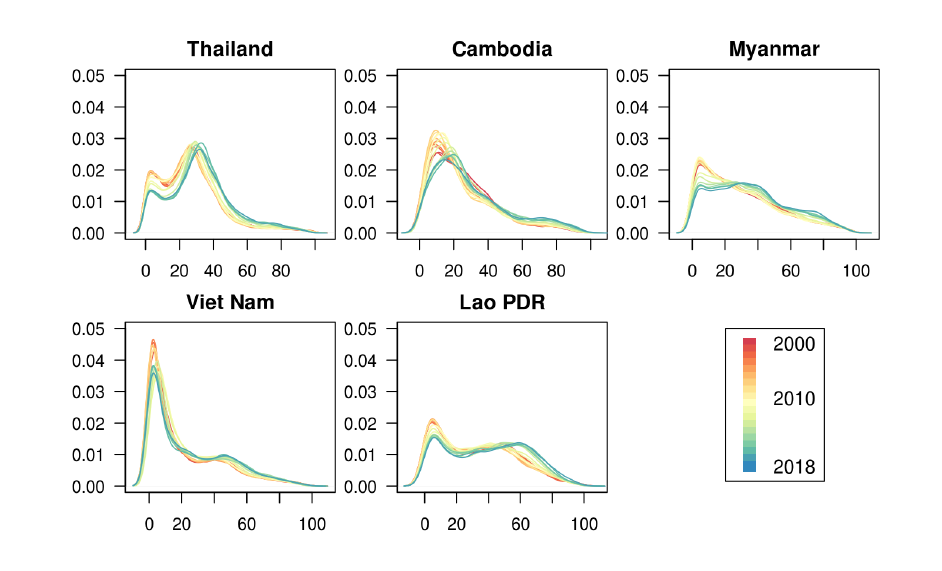
Figure 8. Densities of probability of changes for the ‘Specific to Generic’ forest data per country for the period